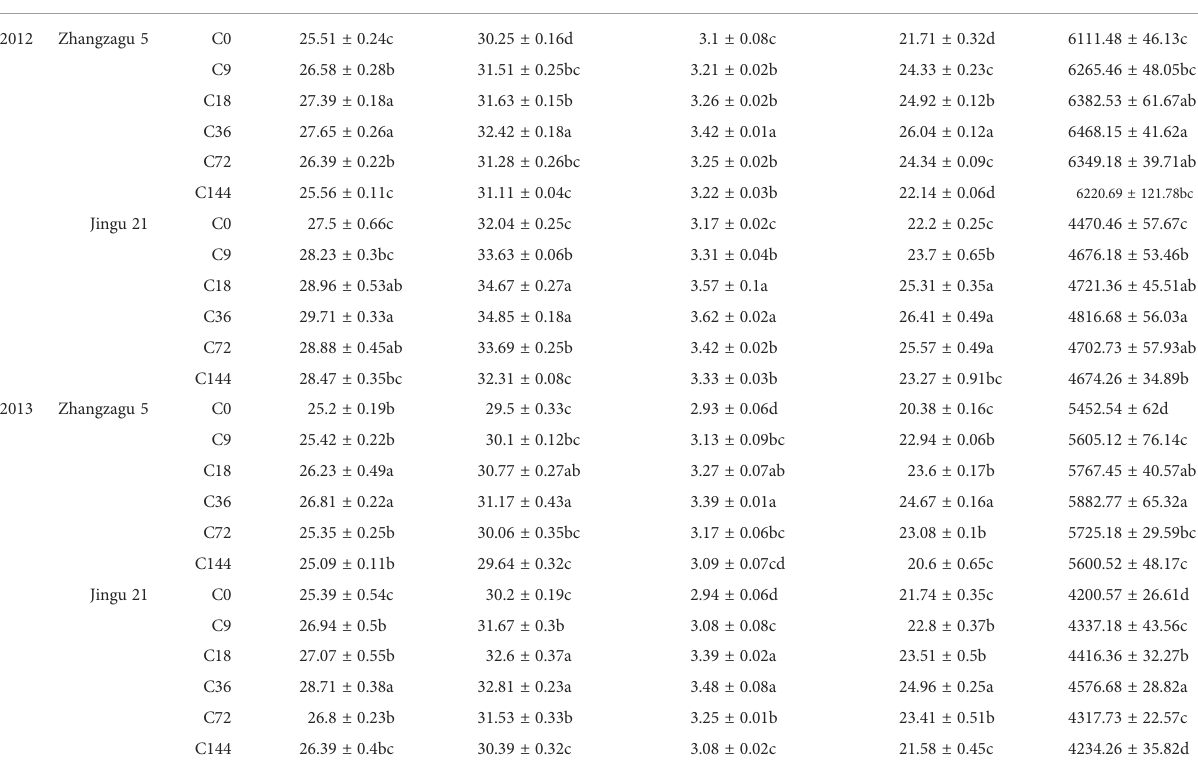
TABLE 4 Effects of naphthalene acetic acid on the yield and yield components of foxtail millet. Year